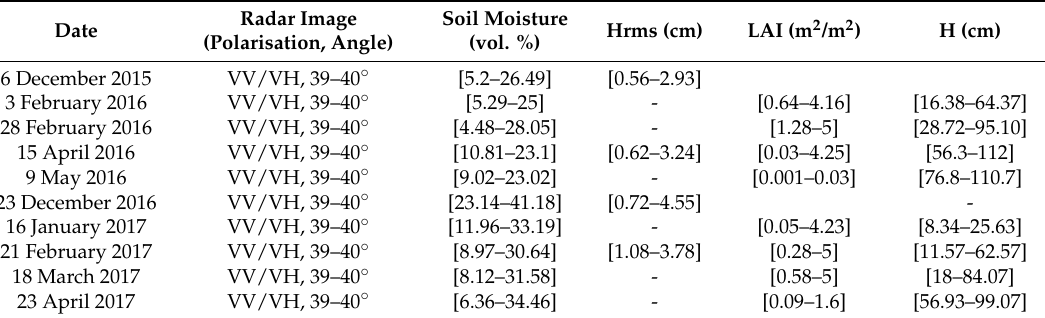
Table 2. Radar and ground measurement campaigns during 2015–2017. Radar image configurations; Root mean square surface height (Hrms); leaf area index (LAI); vegetation height (H).